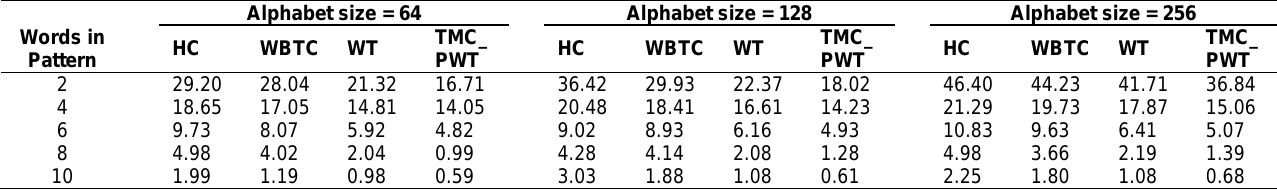
Table 18. Running times of algorithms (for fixed file size = 1024kb)